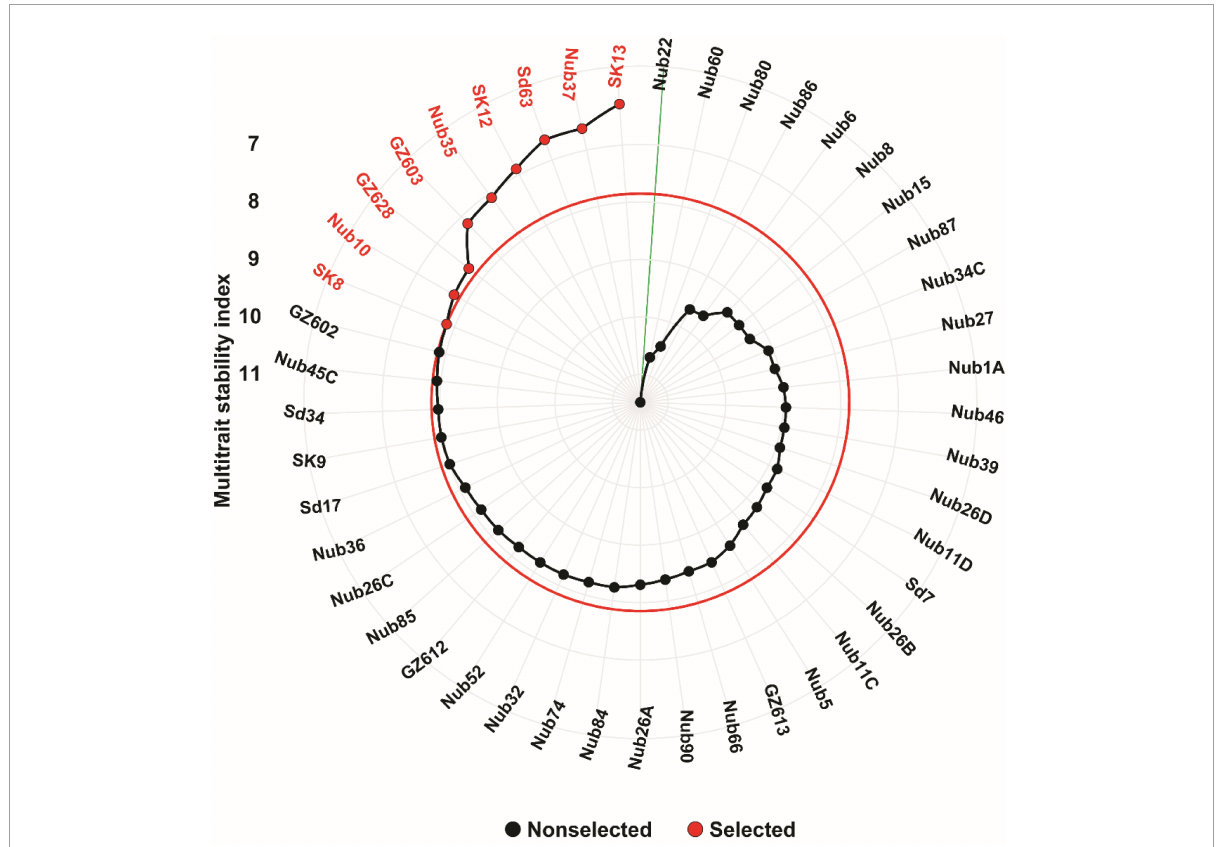
FIGURE6 Ranking of 45 maize inbred lines based on MTSI values performed on 18 traits. The most stable inbred lines are shown in red color and the red circle represents the cut-point according to the selection intensity of 20%. The green line connected to the center of the plot represents the least stable inbred line with highest MTSI